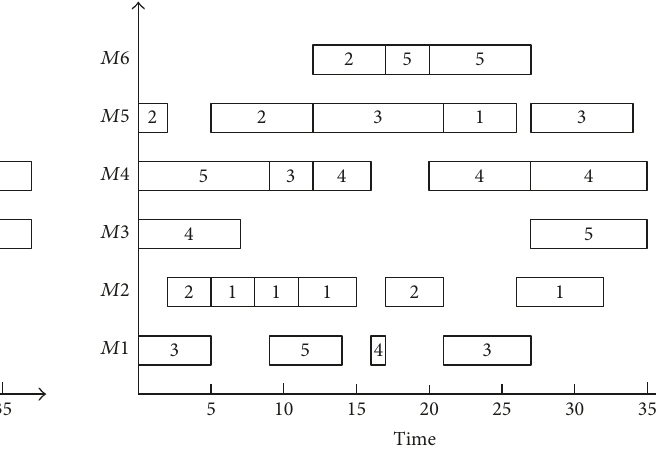
Figure 19: Scheduling Gantt chart for DE3 before optimizing. Figure 20: Scheduling Gantt chart for DE3 after